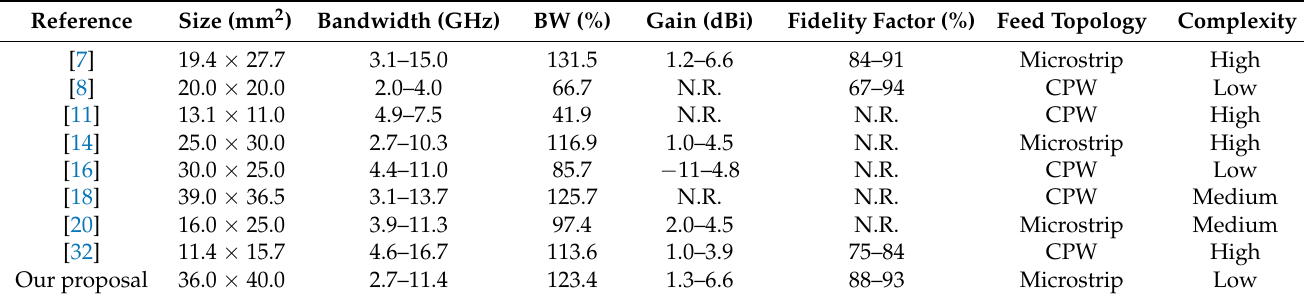
Table 3. Comparative Study of the Antenna Behaviour (N.R. Means Not Reported by Authors).